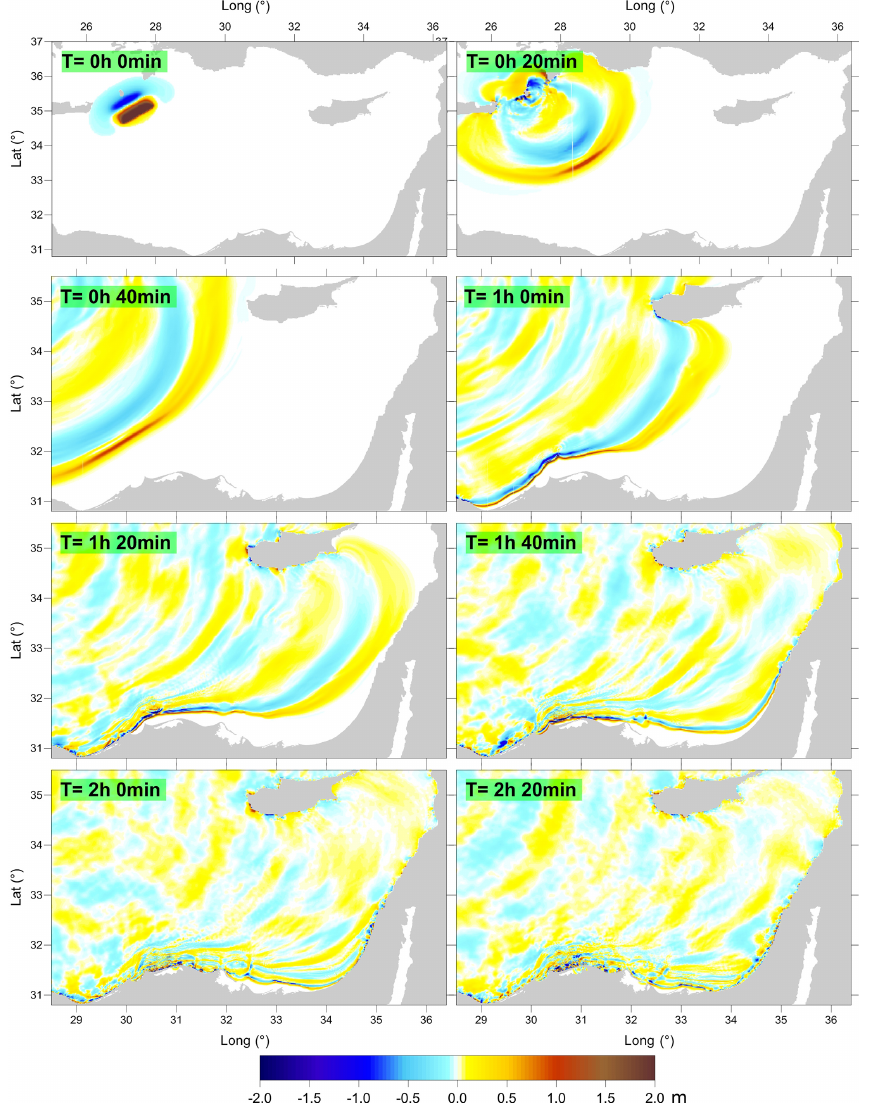
Figure 9. Propagation fields for the EHA tsunami scenario. Snapshots taken every 20min. Fields from t = 0 to t = 20min are plotted in grid 1; the other ones are plotted in grid